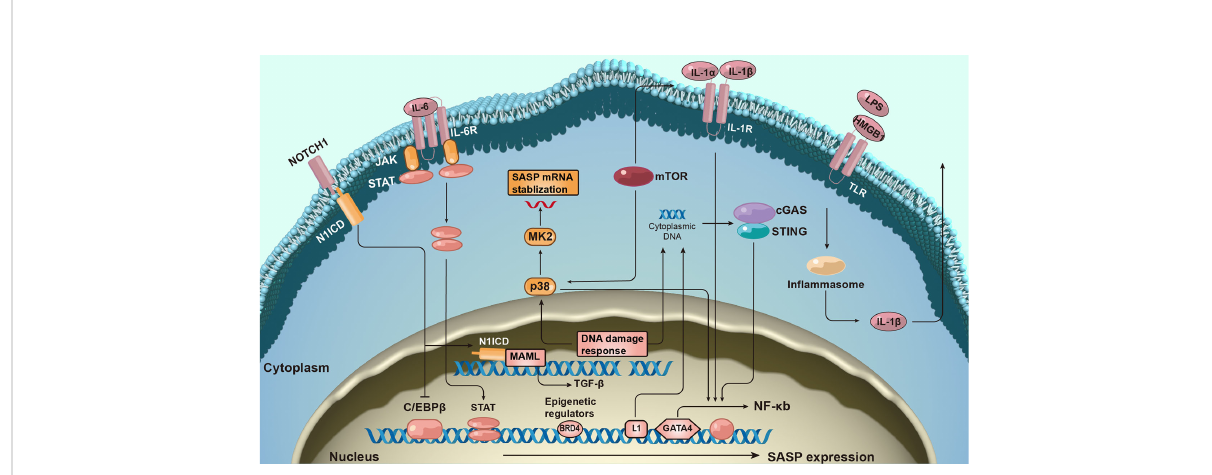
FIGURE 2 The molecular mechanism of senescence-associated secretory phenotype production. The formation of senescence-associated secretory phenotype (SASP) networks in cells is regulated by a complex molecular mechanism. The DNA damage response is related to senescence activation and SASP expression. SASP protein expression is regulated at both the transcription and post-transcriptional levels. Additionally, epigenetic changes regulate SASP gene